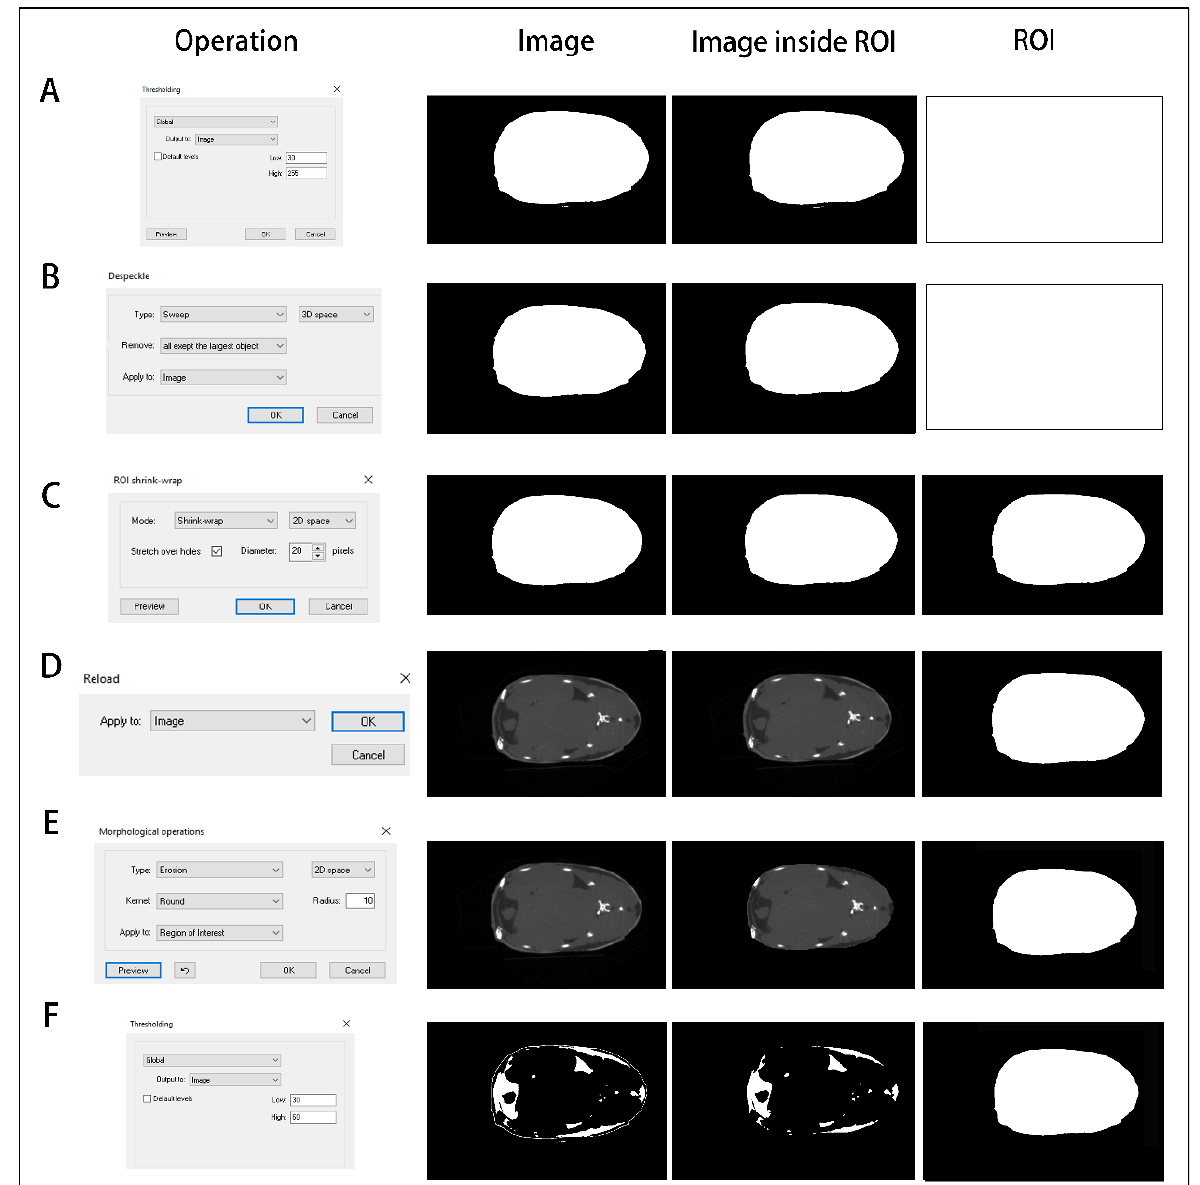
Figure 5. CTAn custom processing task list.